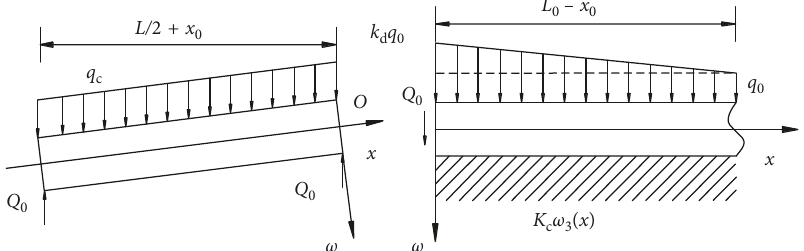
Figure 7: Mechanical model of a hard roof after the initial breakage